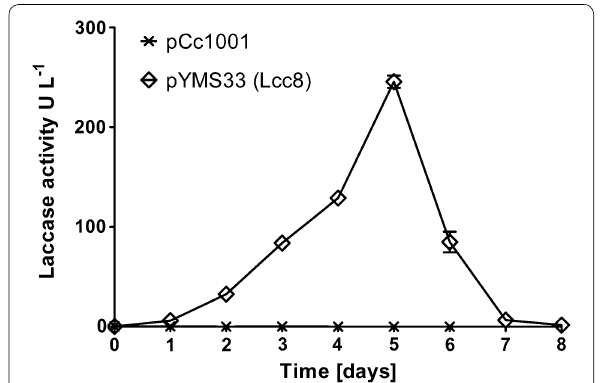
Fig. 1 Laccase activity of pYMS33-12 and pCc1001 cultures. The laccase activity was monitored by ABTS